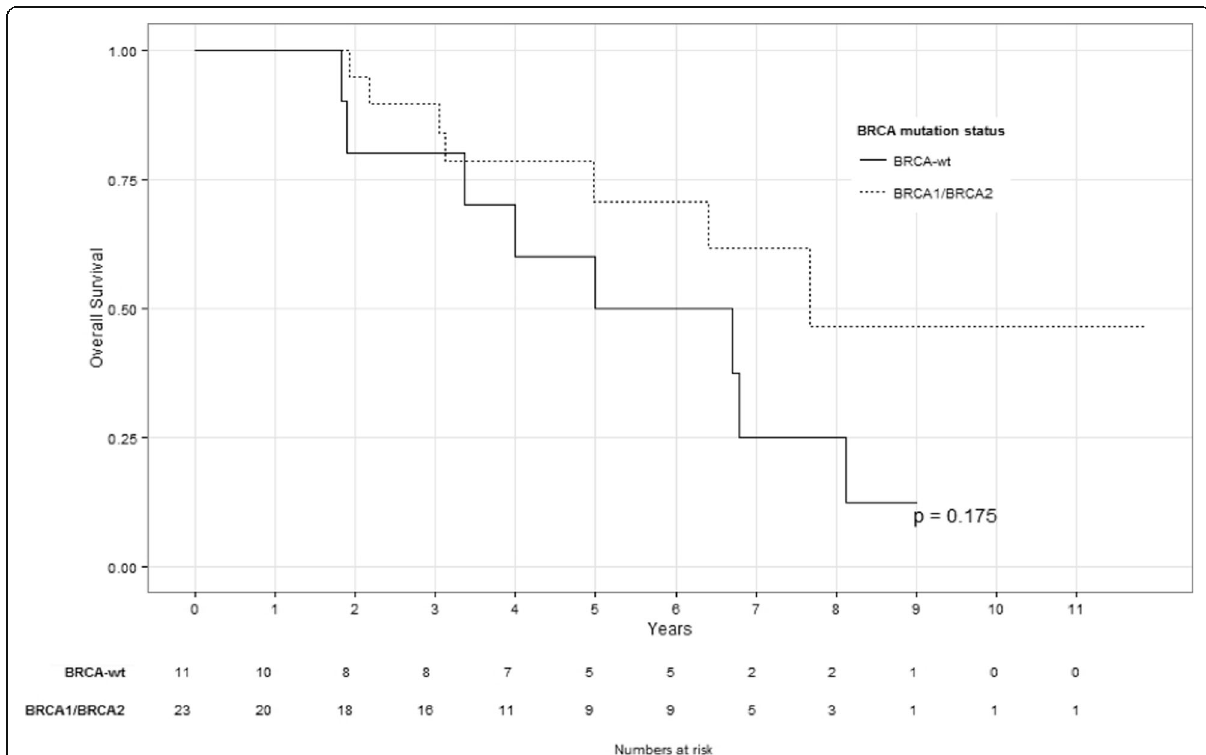
Fig. 7 Overall survival comparison between BRCA-wild type and BRCA1 or BRCA2 mutant HGSC